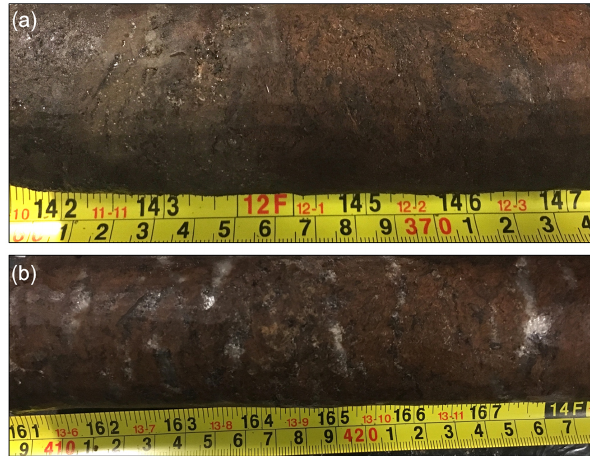
Figure 9. (a) Stratigraphic contact between the base of the frozen silt and peat layer, occurring at 3.65m, and the underlying frozen peat. (b) Example of organic-matrix microlenticular to suspended cryostructures developed in the peat below the stratigraphic contact shown in (a)